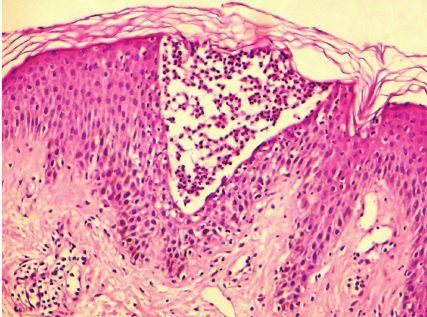
Figure 4: Subcorneal and intraspinous collections of neutrophils with mild epidermal oedema (H and E ×